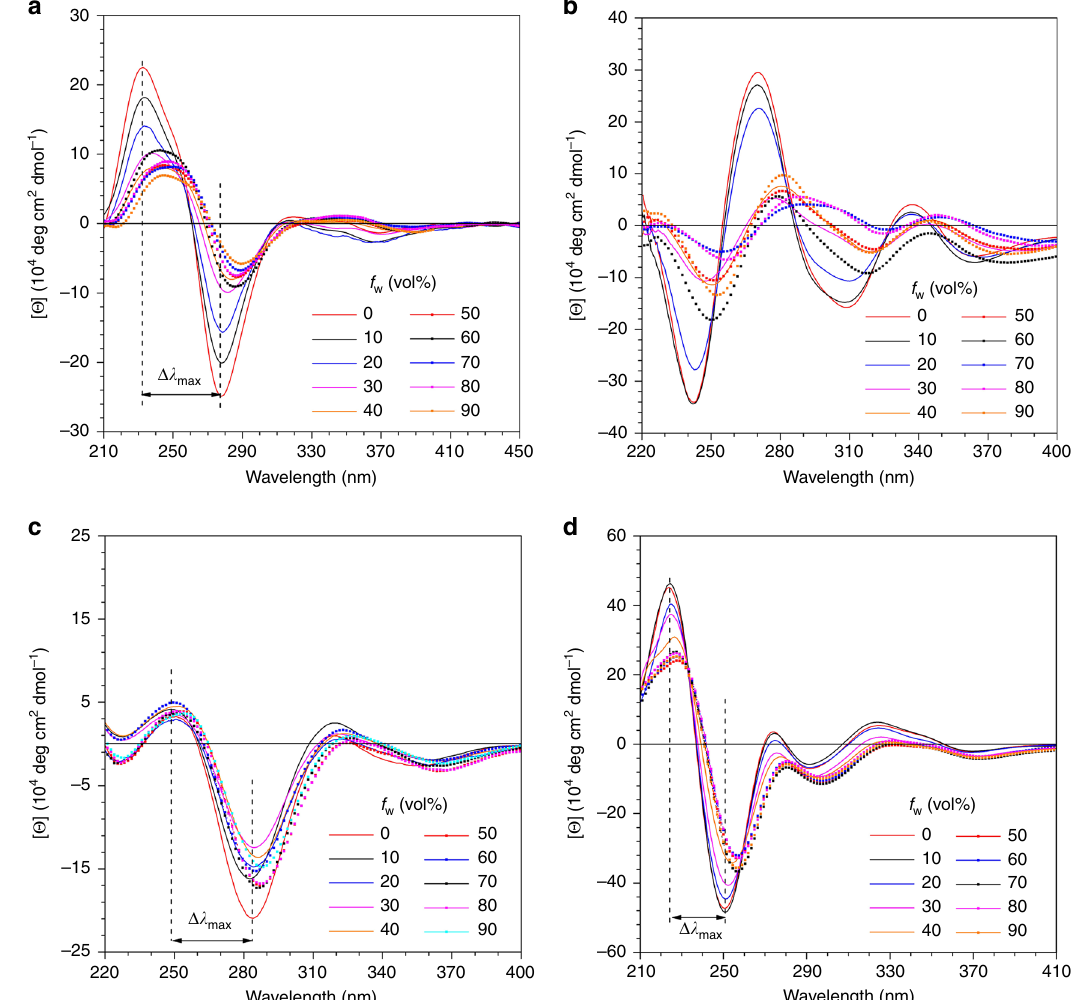
Fig. 3 Circular dichroism spectra. a P- 1 , b P- 2 , c P- 3 , and d P- 4 in THF/water mixtures with different water fractions ( f w ). Concentration: 10 − 4 M